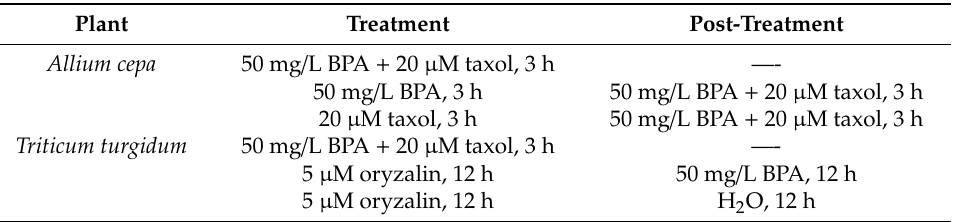
Table 2. Combined treatments with BPA and anti-microtubule